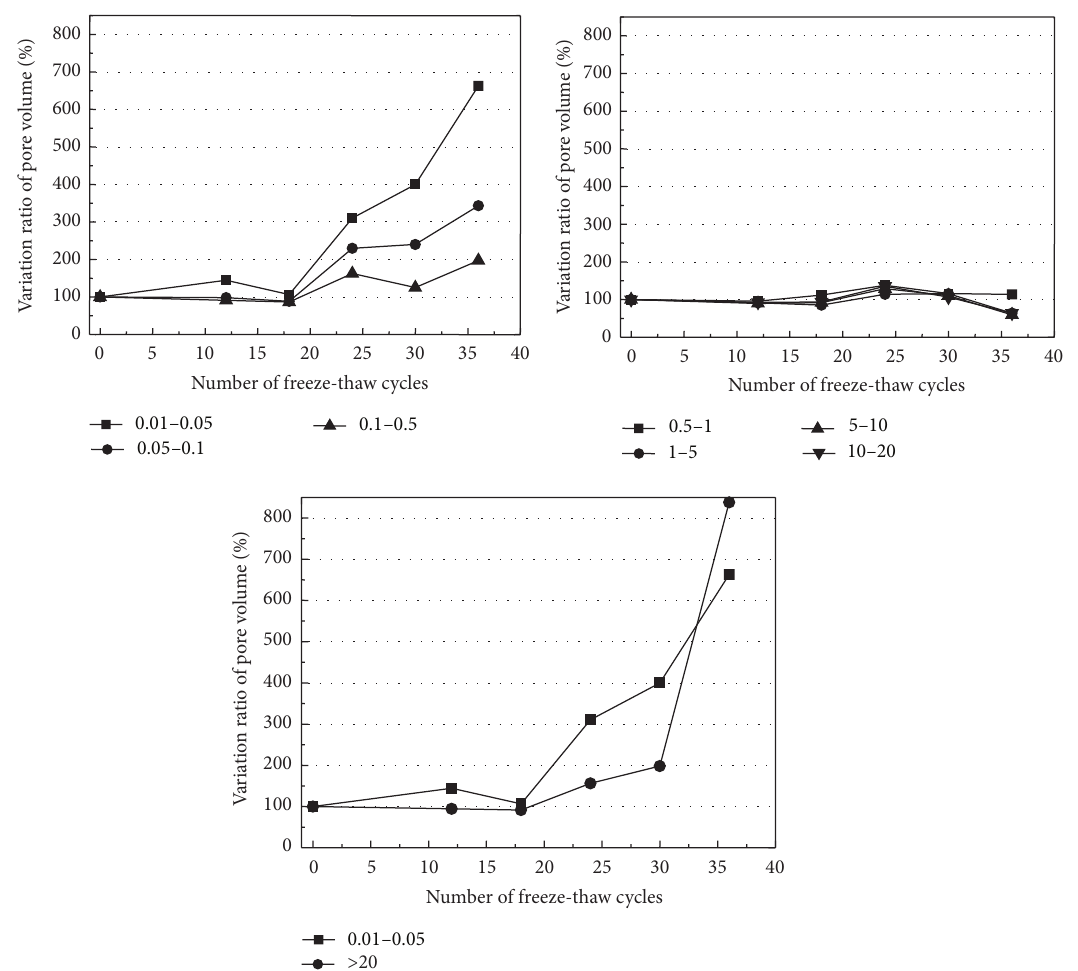
Figure 10: Variation ratio of pore volume of Φ 40 mm circle region of